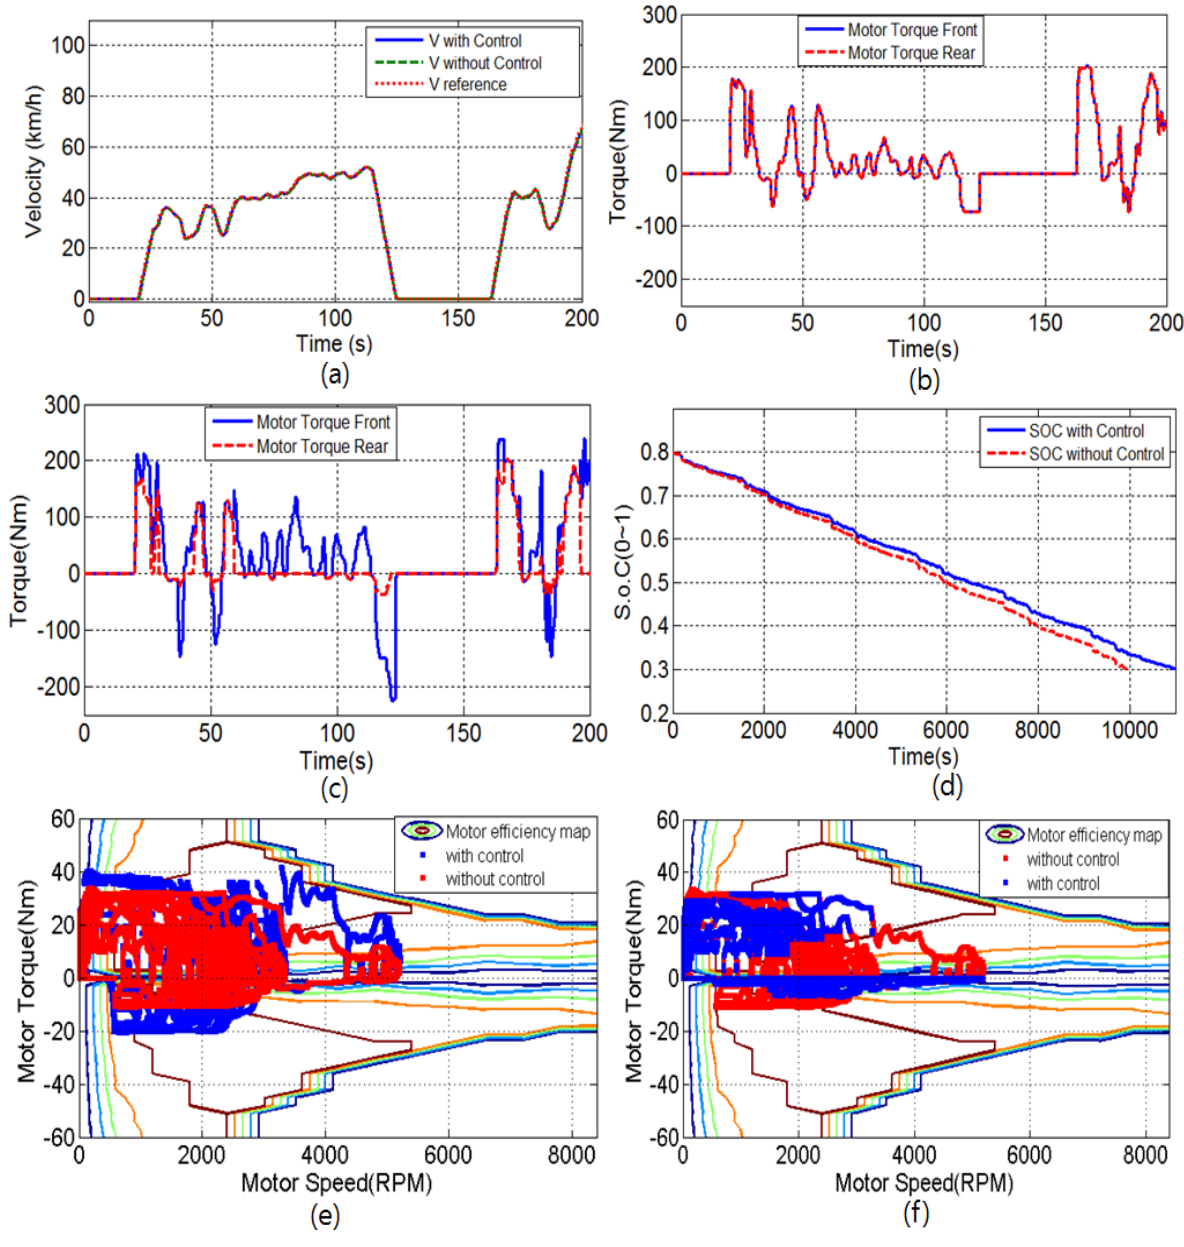
Figure 16. Simulation results in FTP-75 mode for 0–200 s: ( a ) vehicle velocity; ( b ) driving torque of each wheel with control; ( c ) driving torque of each wheel without control; ( d ) battery SOC with and without application of the control algorithm; ( e ) front motor operating point with motor efficiency map; ( f ) rear motor operating point with motor efficiency